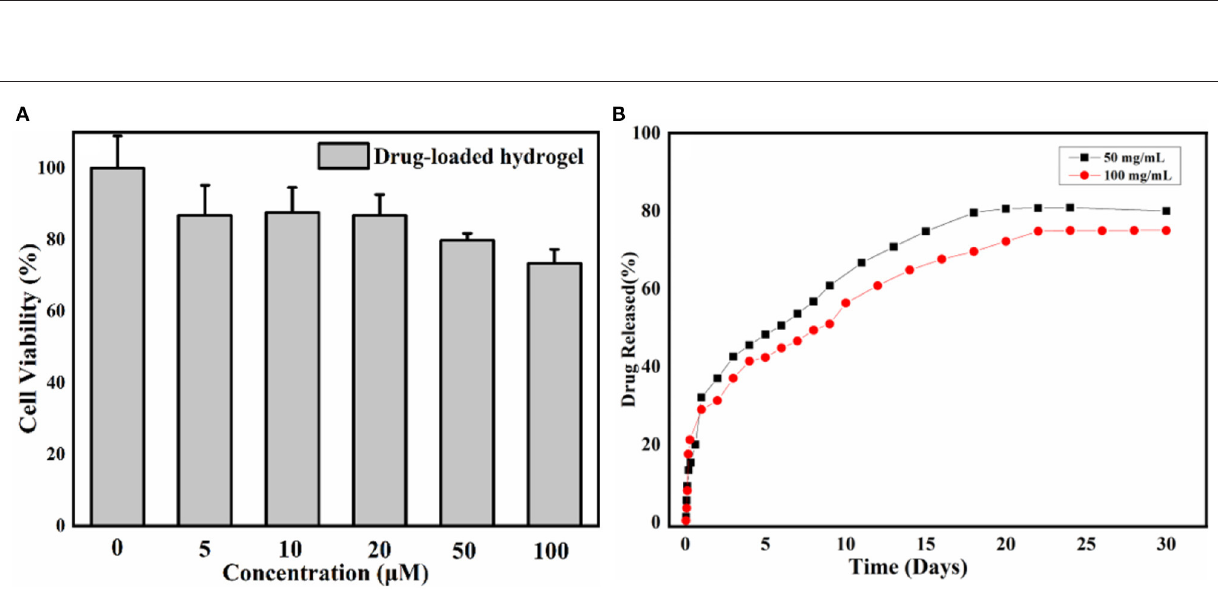
Frontiers in Bioengineering and Biotechnology | www.frontiersin.org